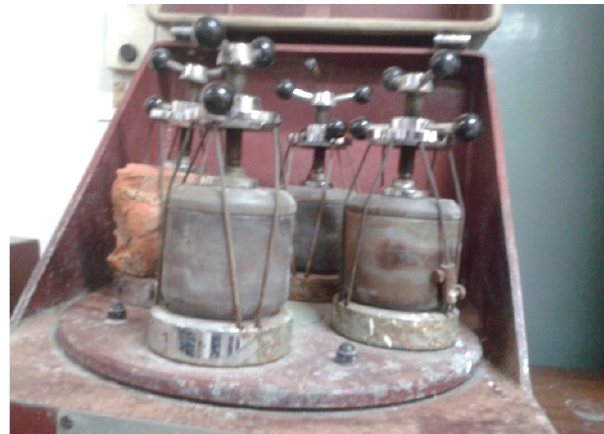
Figure 2. Inside view of ball mill machine.